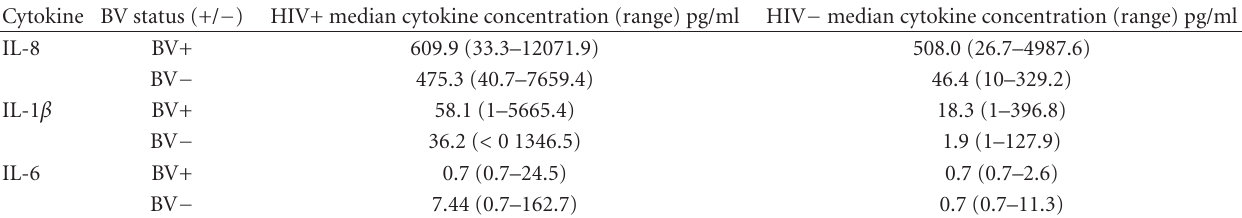
Table 1: Median values and ranges of genital tract IL-8, IL-1 β , and IL-6 concentrations (pg/ml) by bacterial vaginosis (BV) status, stratified by HIV status.